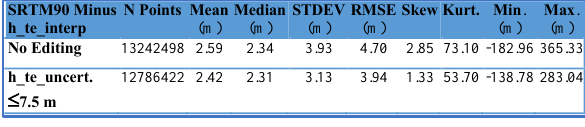
Table 1. Statistics for elevation Differences between SRTM 90 m and ICESat-2 ATL08 h_te_interp (m) shown in Figure 1. Statistics have been computed before editing, and after editing the data for h_te_uncertainty  7.5